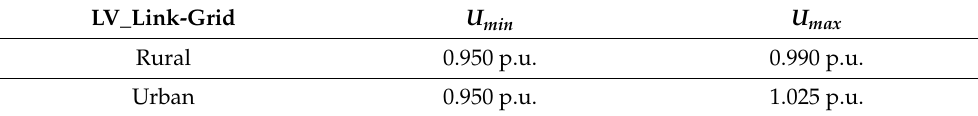
Table 1. Control parameters of the OLTC local control used for both test LV_Link-Grids. LV_Link-Grid U min U max Rural 0.950 p.u. 0.990 p.u. Urban 0.950 p.u. 1.025 p.u.